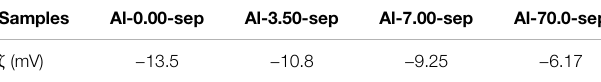
TABLE 6 | The zeta potential of Al-Sep modi fi ed with different dosages of AlCl 3